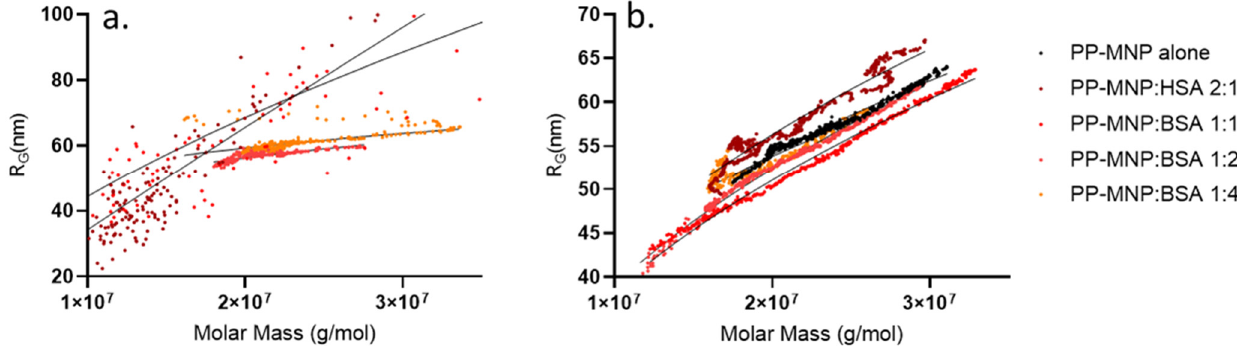
Figure 7. Conformation plots obtained for population 1 ( a ) and population 2 ( b ) expressed as double logarithmic molar mass/gyration radius regression lines.